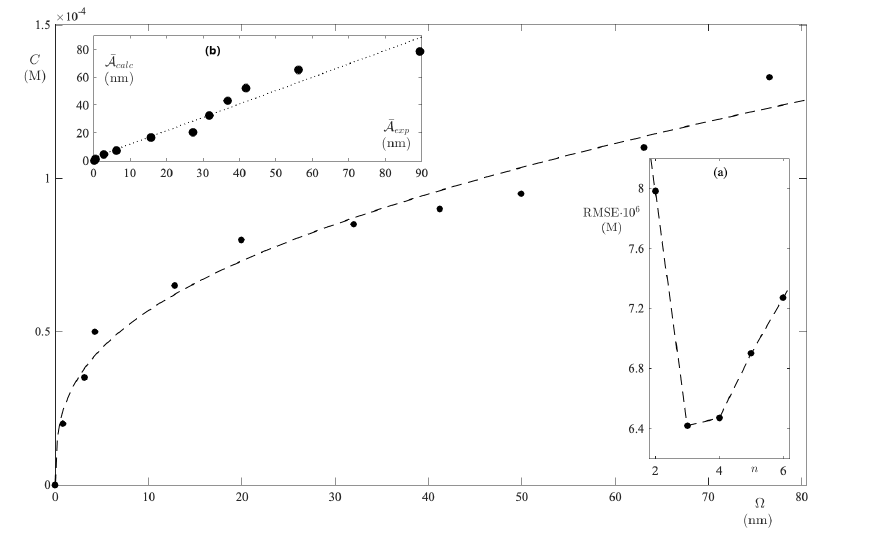
Figure 6. FS molar concentration in ACN as a function of excess absorbance. The dashed curve is the result of fitting to the model equation with n = 3. Panel ( a ) displays the RMSE for each test performed at a different n . Panel ( b ) shows the strong correlation between the integral absorbance that is recalculated with the new parameters, as well as the experimental one.